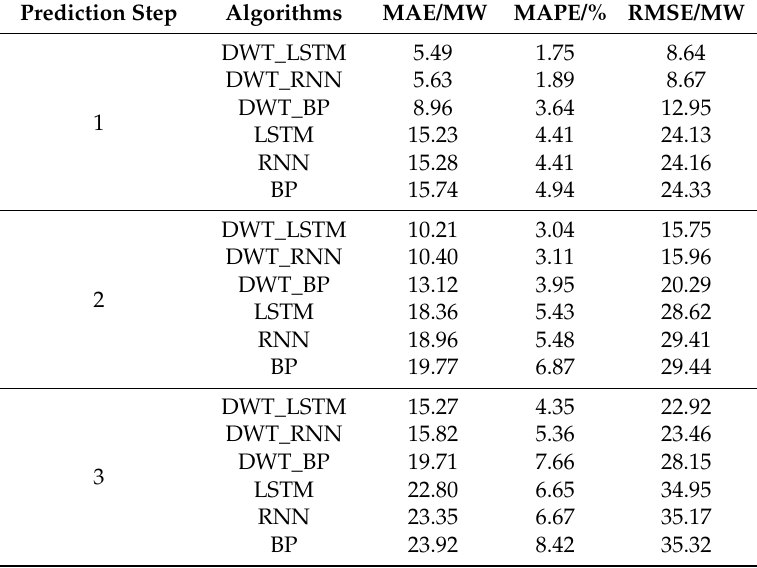
Table 3. Evaluation indexes of farm